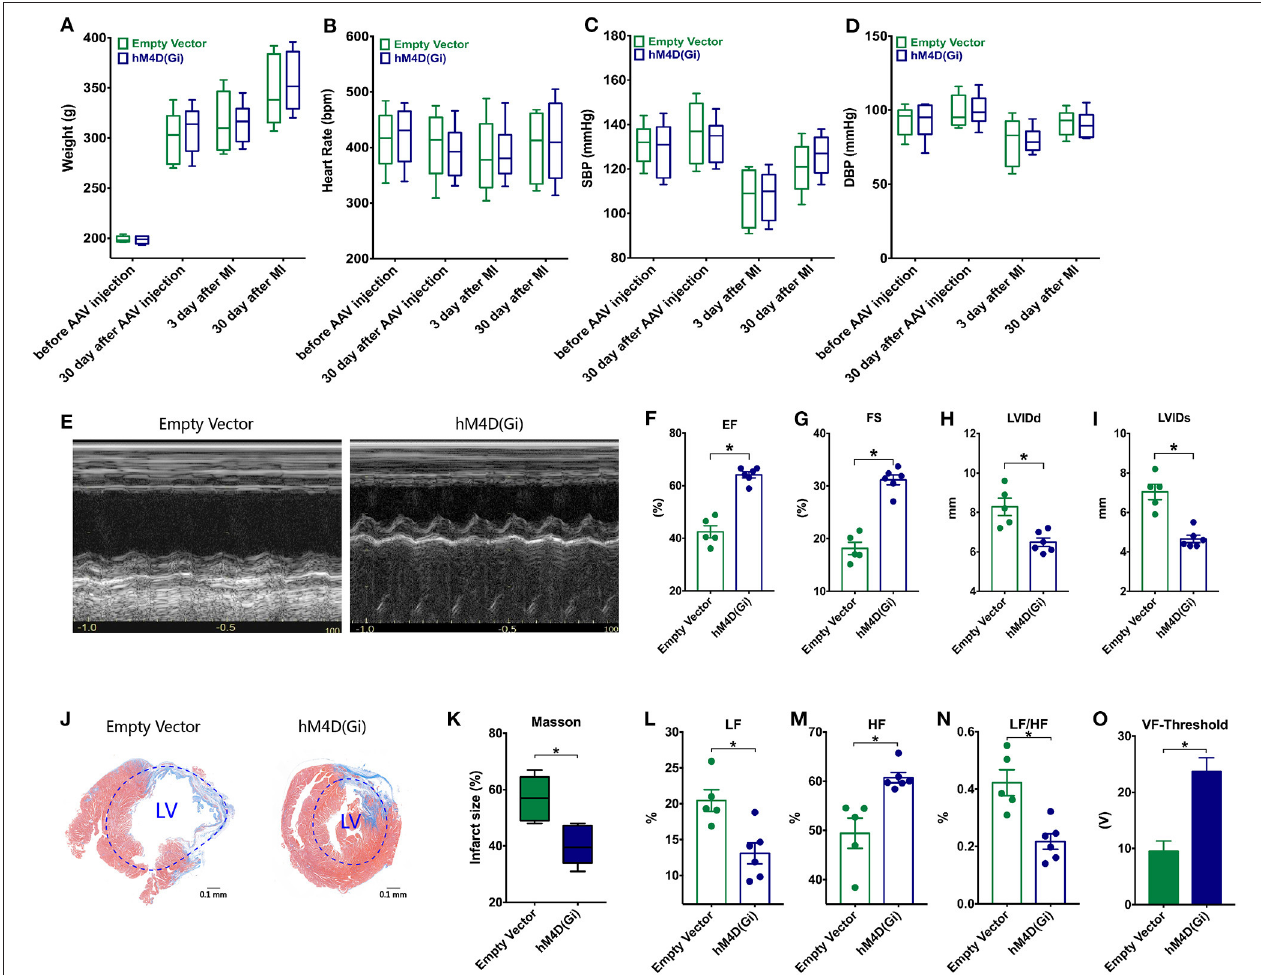
FIGURE 5 | Effects of ganglionic blockade on cardiac dysfunction in a circadian disruption model. (A–D) Difference between weight, heart rate, systolic blood pressure (SBP) and diastolic blood pressure (DBP) of two groups. (E) Representative images of echocardiography. (F–I) Differences of EF, FS, LVIDs, and LVIDd.